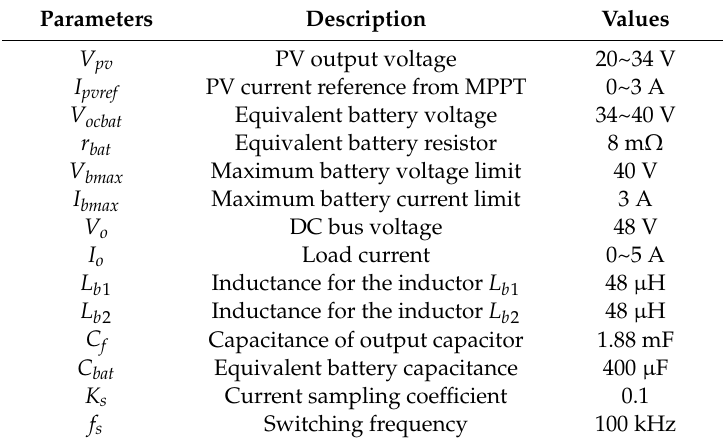
Table 2. The parameters of